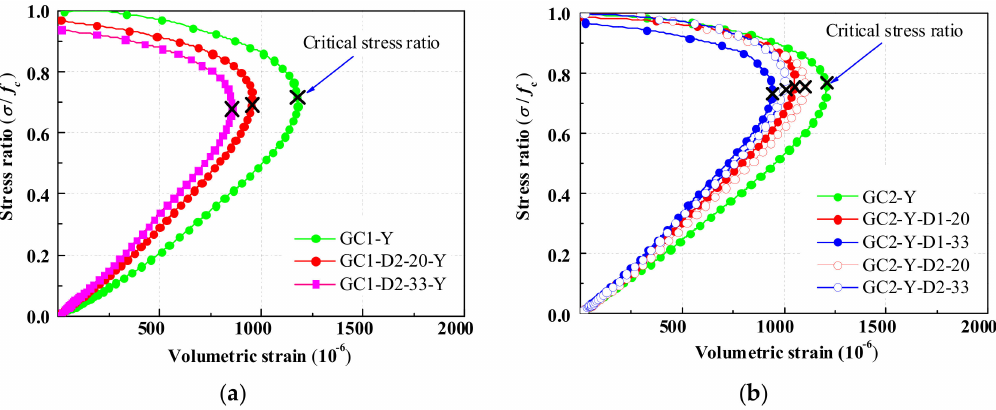
Figure 13. Stress–volumetric strain curve of cylindrical specimens. ( a ) Fresh geopolymer concrete of GC1. ( b ) Fresh geopolymer concrete of